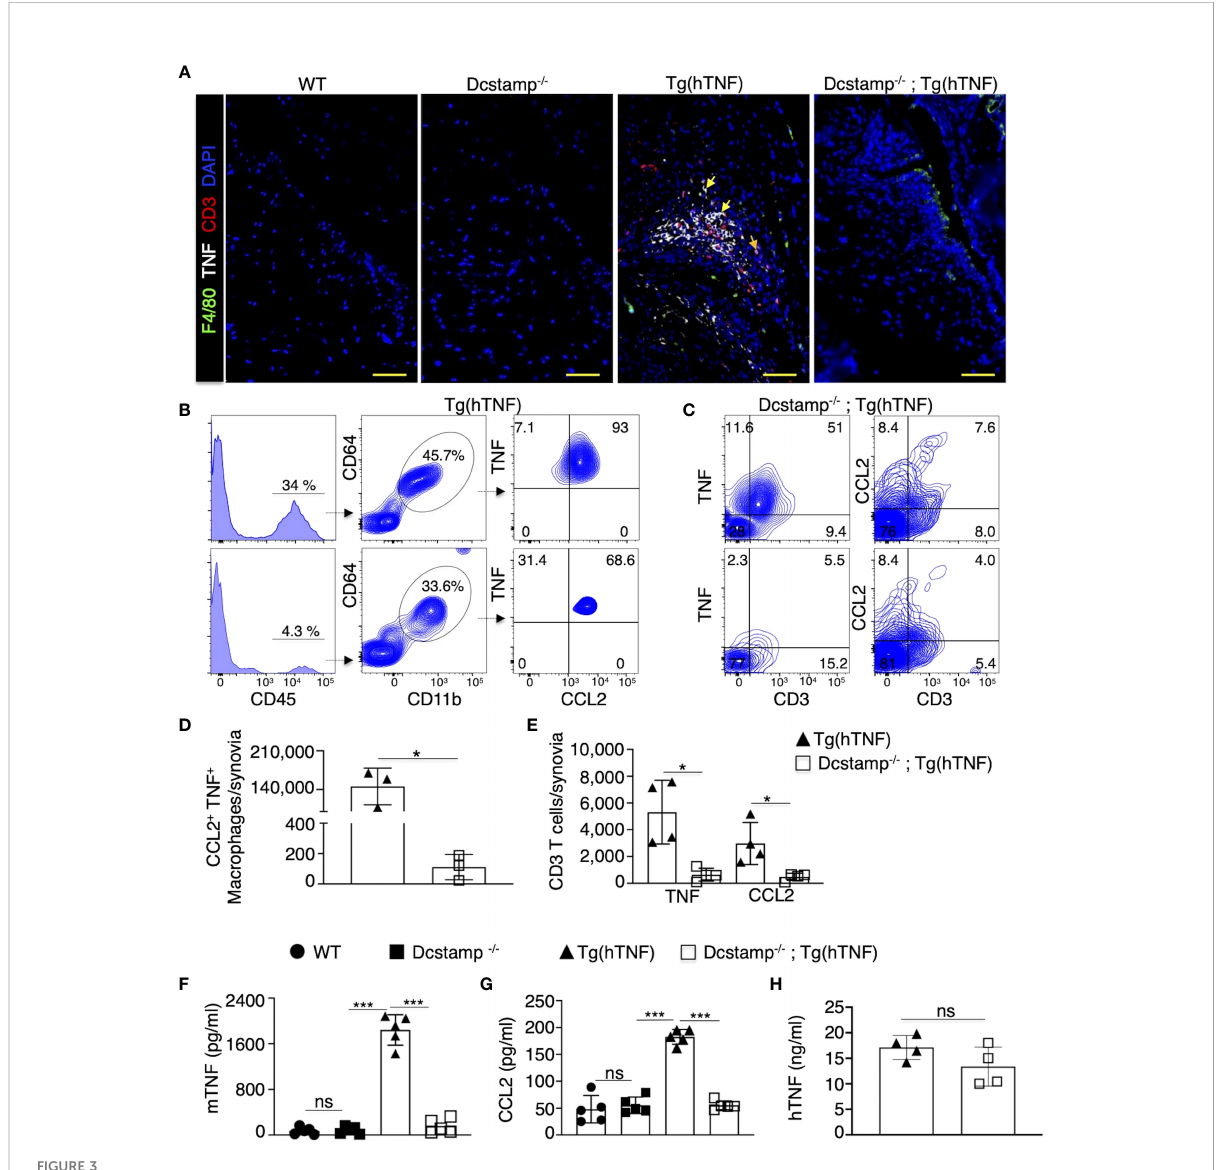
FIGURE 3 Signi fi cant decrease in local and systemic in fl ammation in Tg(hTNF) mice with genetic deletion of DC-STAMP. (A) Joint tissue sections from 5- month-old WT, Tg(hTNF), Dcstamp -/- and Dcstamp -/- ;Tg(hTNF) female mice were stained with antibodies against TNF (white), F4/80 (green) and CD3 (red). (A) signi fi cant decrease in the accumulation of in fl ammatory cells was observed in synovia from Dcstamp -/- ;Tg(hTNF) mice. Representative 200x magni fi cation pictures from fi ve mice in each group were taken with a Zeiss Axioplan microscope and recorded with a Hamamatsu camera. (B, C) Tg(hTNF) mice demonstrated a lower frequency and total number of CCL2 and F4/80 macrophages and CD3 (D, E) in the synovium from the knee (n = 4; paired Student's t-test). (F – H) Serum from WT, Tg(hTNF), Dcstamp -/- and Dcstamp -/- ;Tg(hTNF) mice were collected at fi ve months of age and human TNF, mouse TNF and CCL2 amounts were analyzed with the LEGENDplex TM in fl ammation panel assay. Murine TNF levels were signi fi cantly higher in the Tg(hTNF) compared to the mice with DC-STAMP deletion. Graphs represent mean ± SD (n = 5). *p ≤ 0.05, ***p < 0.0005, ns, not statistically signi fi cant (two-ways ANOVA and Tukey's test) (E) human TNF in serum was measured by ELISA, graph show similar levels of hTNF in Tg(hTNF) and Dcstamp -/- ;Tg(hTNF) mice. Graph represents the mean ± SD (n = 4 ). ns; no signi fi cance (paired Student's